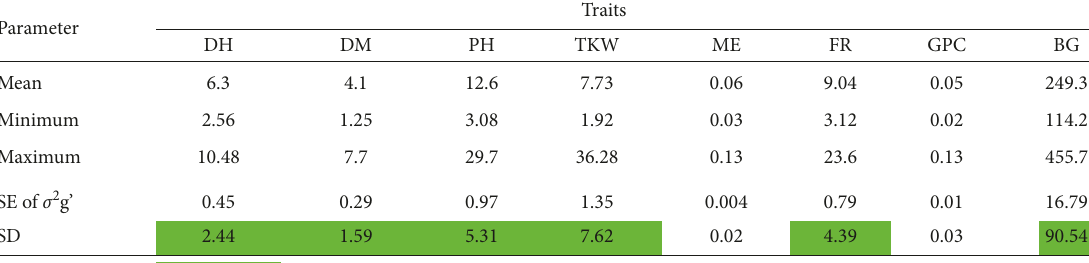
g ) among RILs within crosses estimated from 900F4:5 based on the 30 malt Traits